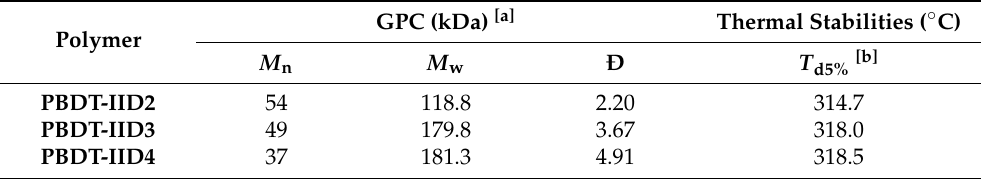
Table 1. The molecular weights and thermal stabilities of PBDT-IIDs.